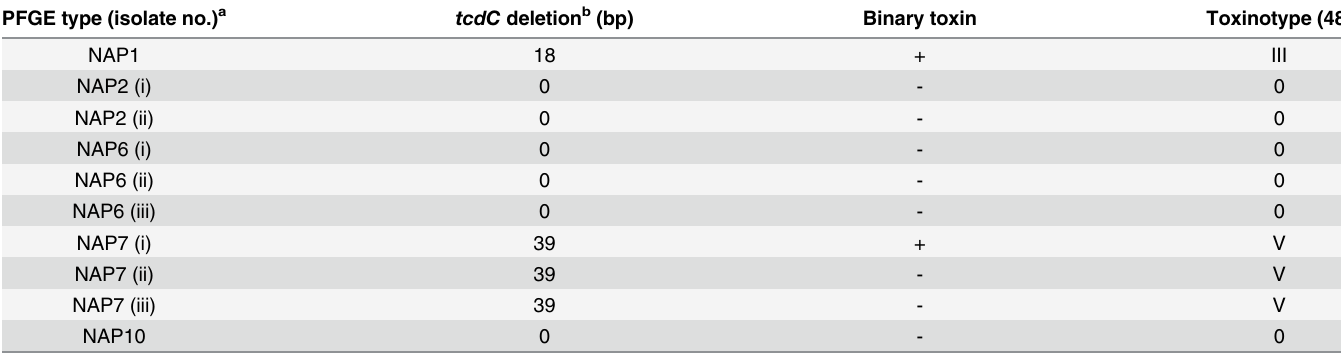
Table 2. Characteristics of Clostridium difficile isolates used in this study. PFGE type (isolate no.)